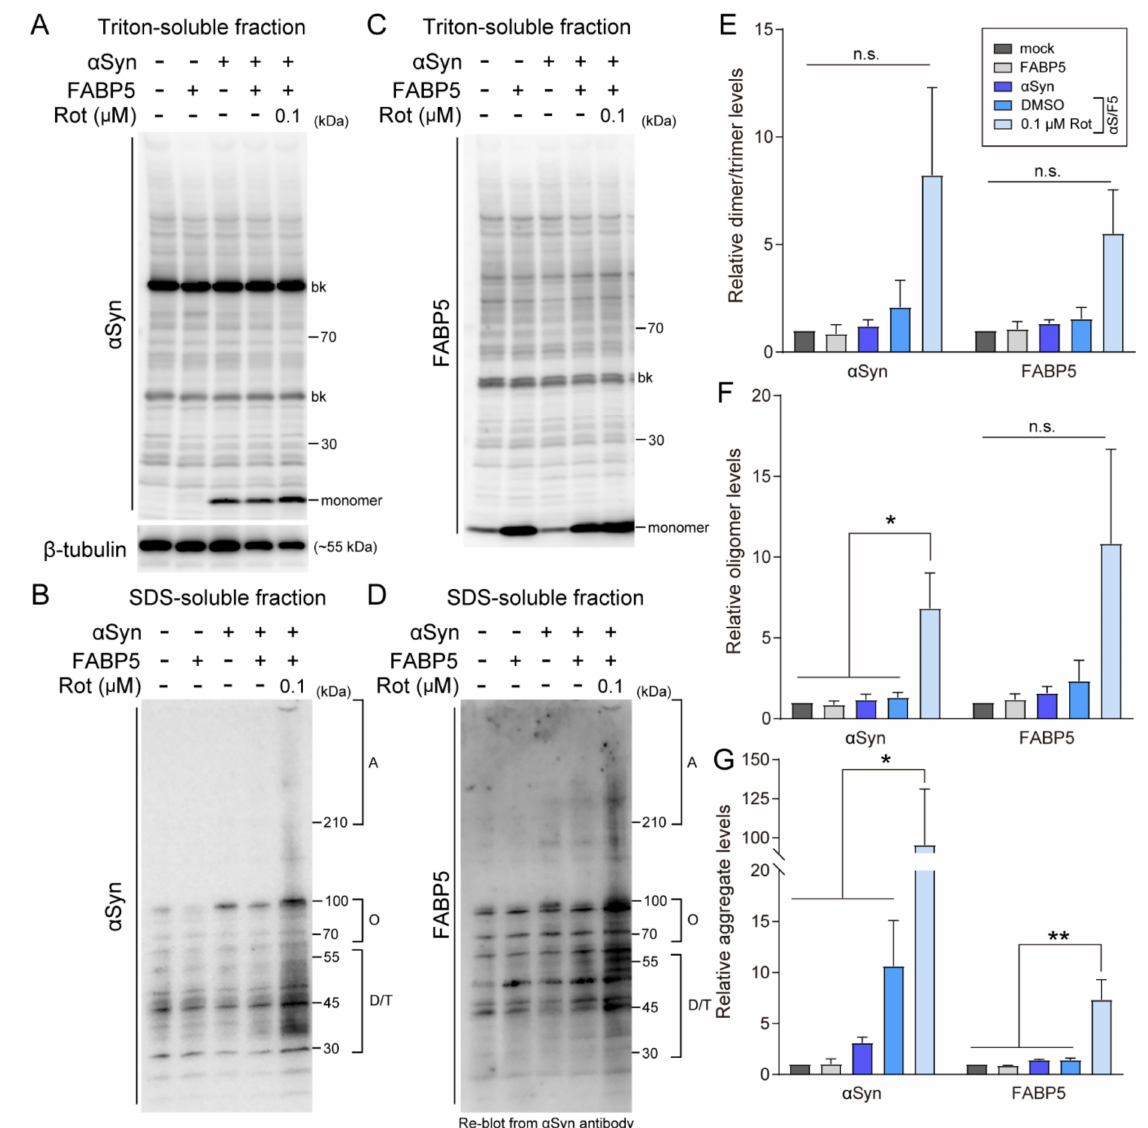
Figure 2. Effects of rotenone on α Syn oligomerization and aggregation in FABP5/ α Syn-transfected Neuro-2A cells. ( A – D ) Representative images of immunoblots probed with antibodies against α Syn and FABP5 under non-denaturing conditions of Triton-soluble and SDS-soluble fractions. Detection with anti- β -tubulin antibody was used as a protein-loading control. ( E – G ) Quantitative analyses of protein contents of different molecular weights, which indicate protein complexes of dimer/trimers, oligomers, and aggregates. Results are presented as means ± SEM ( n = 3 respective cell experiments). * p < 0.05, ** p < 0.01, vs. 0.1 µ M rotenone-treated α S/F5 cells. n.s., not statistically significant. D/T: dimers/trimers; O: oligomers; A: aggregates. bk besides blots indicate non-specific